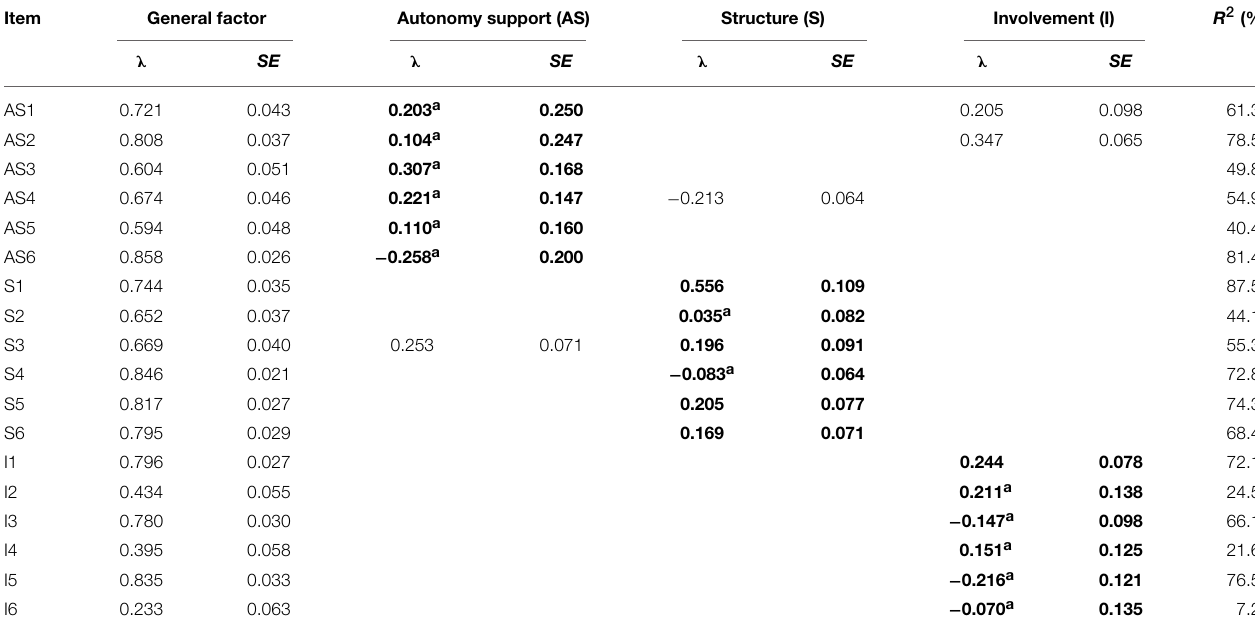
TABLE 4 | Standardized Loading Pattern for the Bifactor ESEM of the ISS-C ( N = 277 ). Item General factor Autonomy support (AS) Structure (S) Involvement (I) R 2